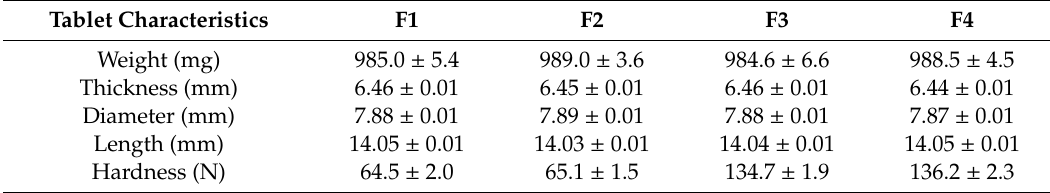
Table 5. Characterization of the di ff erent batches of PAMgA matrix